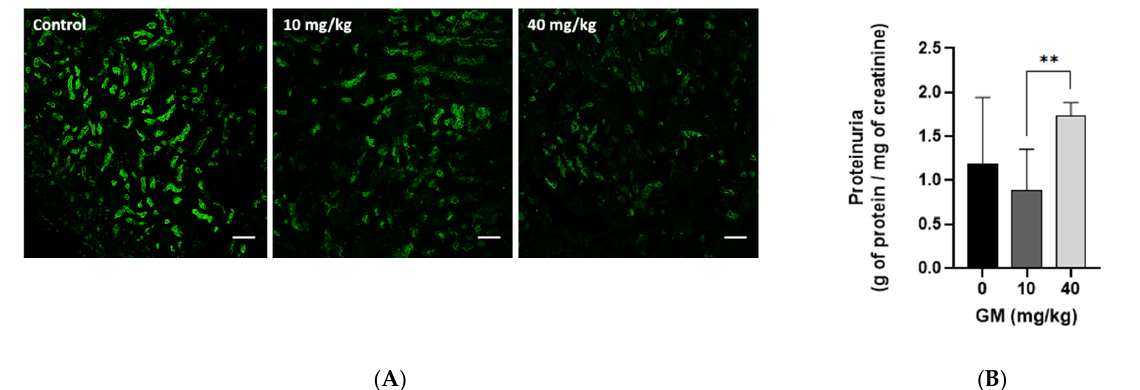
Figure 6. Administration of 10 mg/kg of GM decreases the levels of megalin receptor in PT but does not increase urinary excretion of proteins. ( A ) Expression pattern of megalin receptor (green fluorescence) in renal tissue after exposure to 10 and 40 mg of GM/kg/day. Scale bars represent 50 µm; ( B ) Administration of 10 mg/kg of GM does not increase urinary protein excretion of C57BL/6J mice. Bar graph shows means ± SD, n = 5 animals per dose. One-way ANOVA was performed, p = 0.0559. Post-hoc: Dunn test ** p < 0.025.